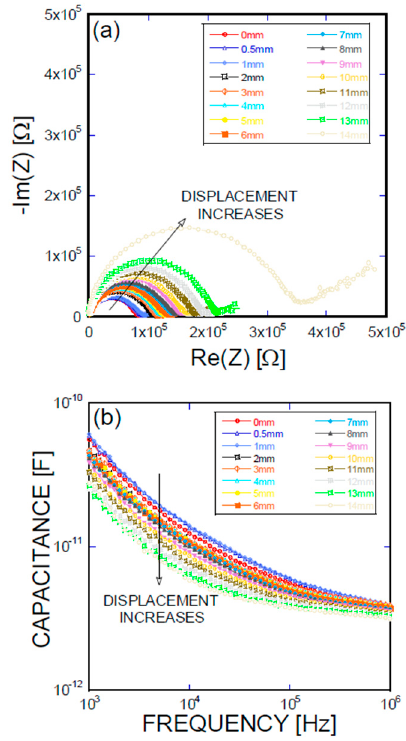
Figure 7. ( a ) Impedance spectra and capacitance Bode plots as a function of displacement obtained for a DL-type Ni/Ti SMA fiber pullout; ( b ) mechanical load and electrical resistance extracted as a function of wire displacement obtained for a DL-type Ni/Ti SMA fiber pullout.